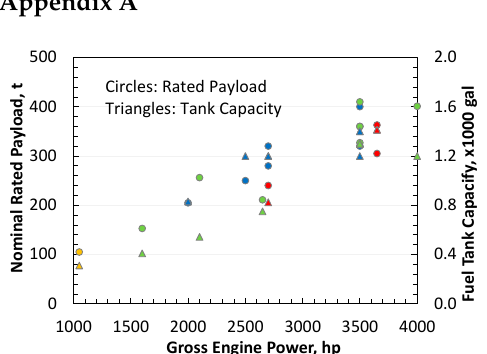
Figure A1. Nominal engine size, payload (filled circles), and fuel tank capacities (filled triangles) of commercially available MW-class haul trucks. The data are color-coded (green, blue, red and yellow) to distinguish the equipment manufacturers (Caterpillar, Komatsu, Liebherr and Terex) and were gathered from the websites maintained by them. It was only used in this work for selecting the baseline engine size and guiding discussions.